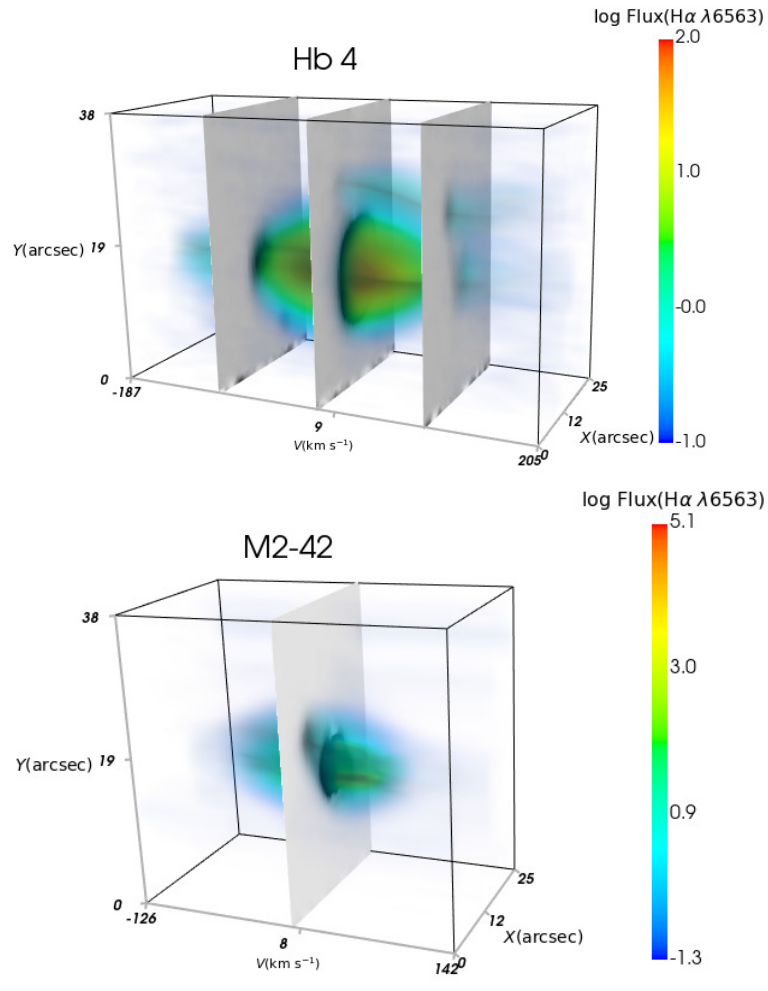
Figure 5. PPV cubes of Hb4 ( top panel ) and M2-42 ( bottom panel ) with 3 slices at − 104, 0, and + 102 kms − 1 for Hb4, and a slice at − 2 kms − 1 for M2-42. Velocity slices of Hb4 and M2-42 are presented in Danehkar [29] and Figure 1,